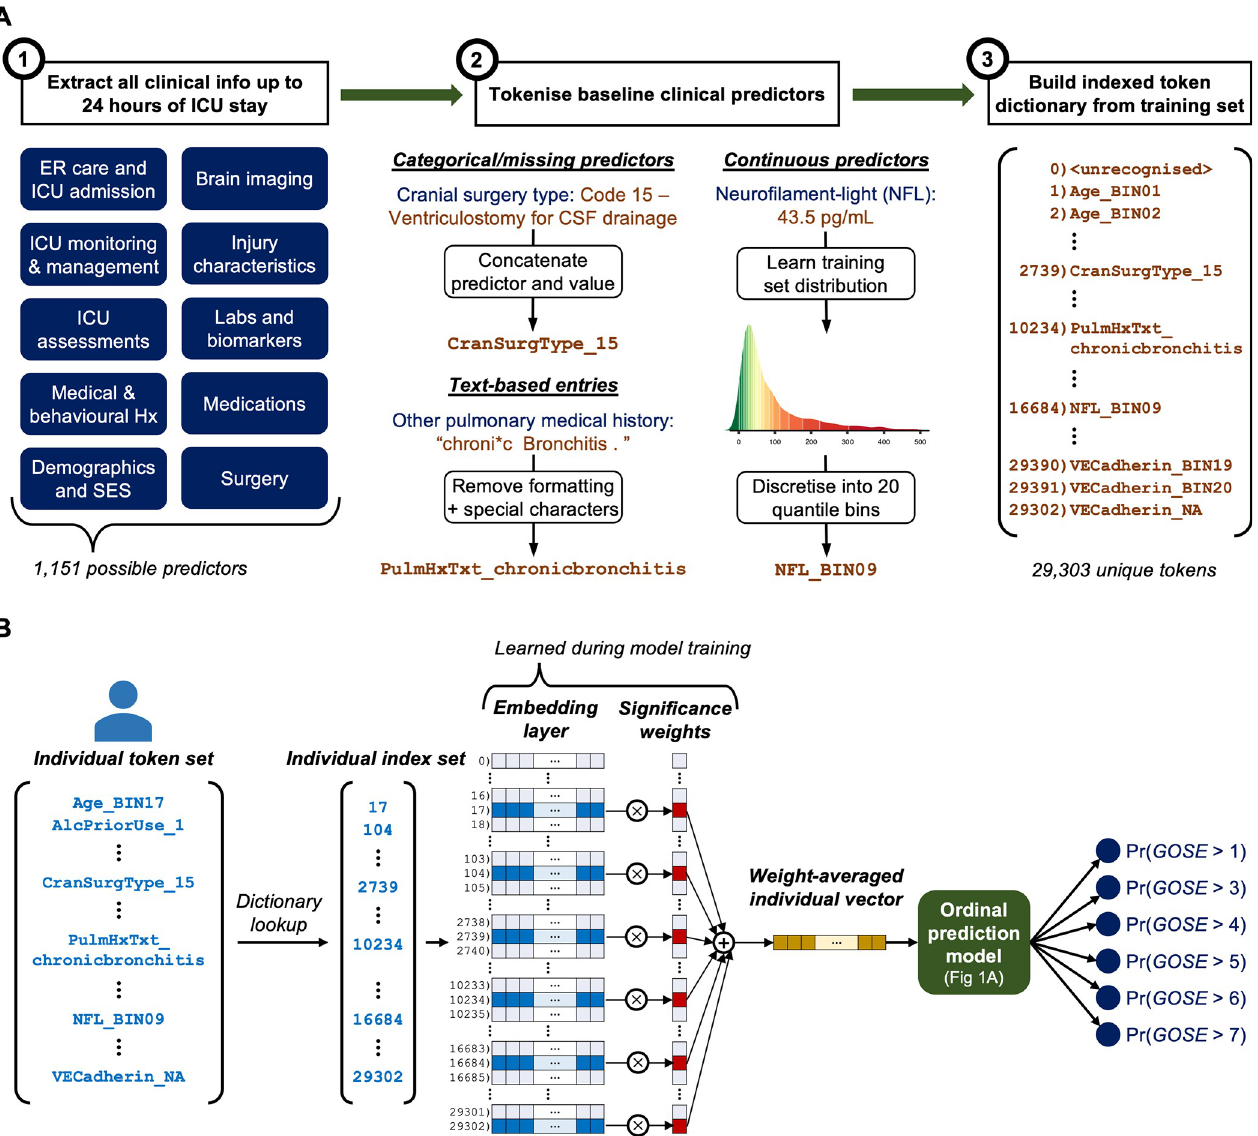
Fig 2. Tokenisation and embedding procedure for the development of ordinal all-predictor-based models (APMs). ICU = intensive care unit. ER = emergency room. Hx = history. SES = socioeconomic status. CSF = cerebrospinal fluid. GOSE = Glasgow Outcome Scale–Extended at 6 months post- injury. ( A ) Process of converting all clinical information, from the first 24 hours of each patient, into an indexed dictionary of tokens during model training. The tokenisation process is illustrated with three example predictors and their associated values in step 2. The first entry in the trained token dictionary (‘0) < unrecognised > ‘) of step 3 is a placeholder token for any tokens encountered in the testing set that were not seen in the training set. ( B ) Visual representation of token embedding and significance-weighted averaging pipeline during APM prediction runs. After tokenising an individual patient’s clinical information, the vector of tokens is converted to a vector of the indices corresponding to each token in the trained token dictionary. The corresponding vectors and significance weights of the indices are extracted to weight-average the patient information into a single vector. The embedding layer and significance weights are learned through stochastic gradient descent during model training, and significance weights are constrained to be positive with an exponential function. While not explicitly shown, the weighted vectors are divided by the number of vectors during weight-averaging. The individual, weight-averaged vector then feeds into an ordinal prediction model to return probabilities at each GOSE threshold. The ordinal prediction model could either have multinomial output encoding (APM MN ) or ordinal outcome encoding (APM OR ), as represented in Fig 1A